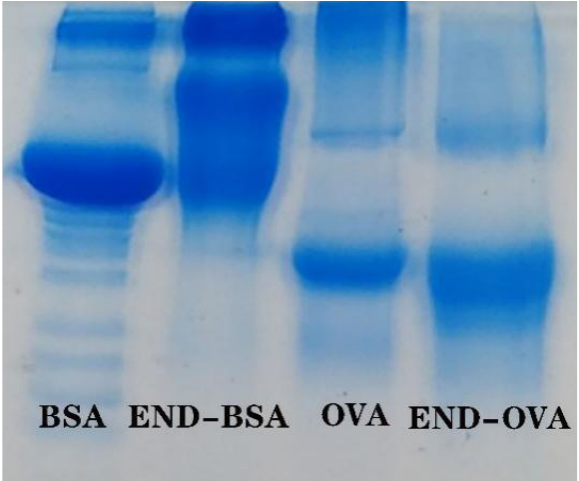
Figure 5. Native PAGE of immunogen and coating antigen of endosulfan.